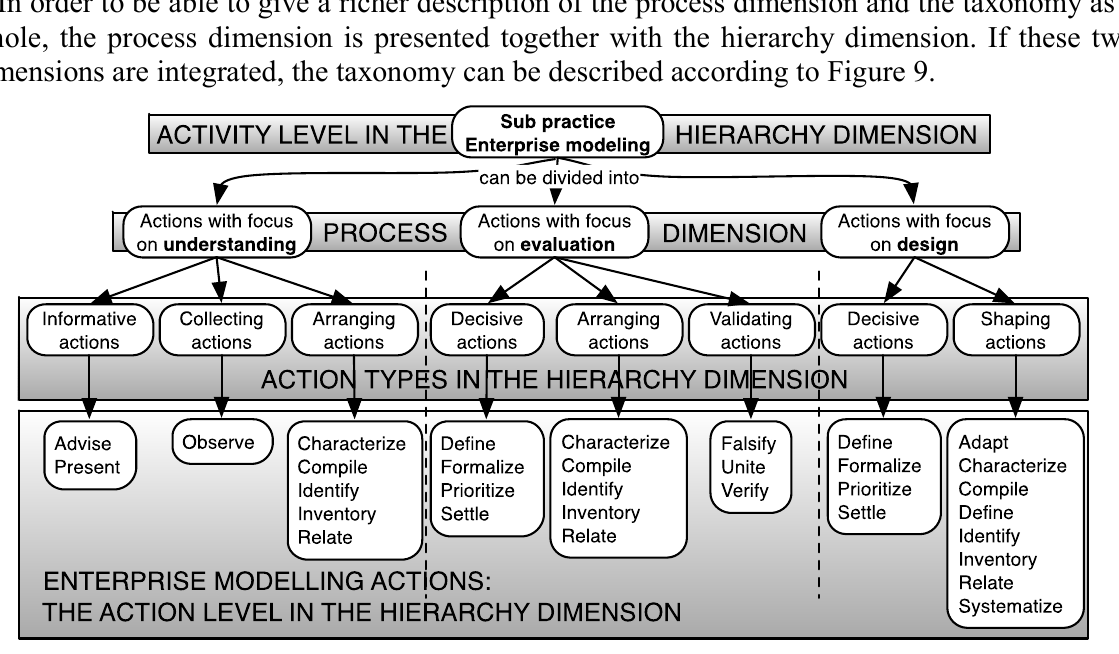
Figure 9. Conceptualization of EM actions and integration of the hierarchy and process